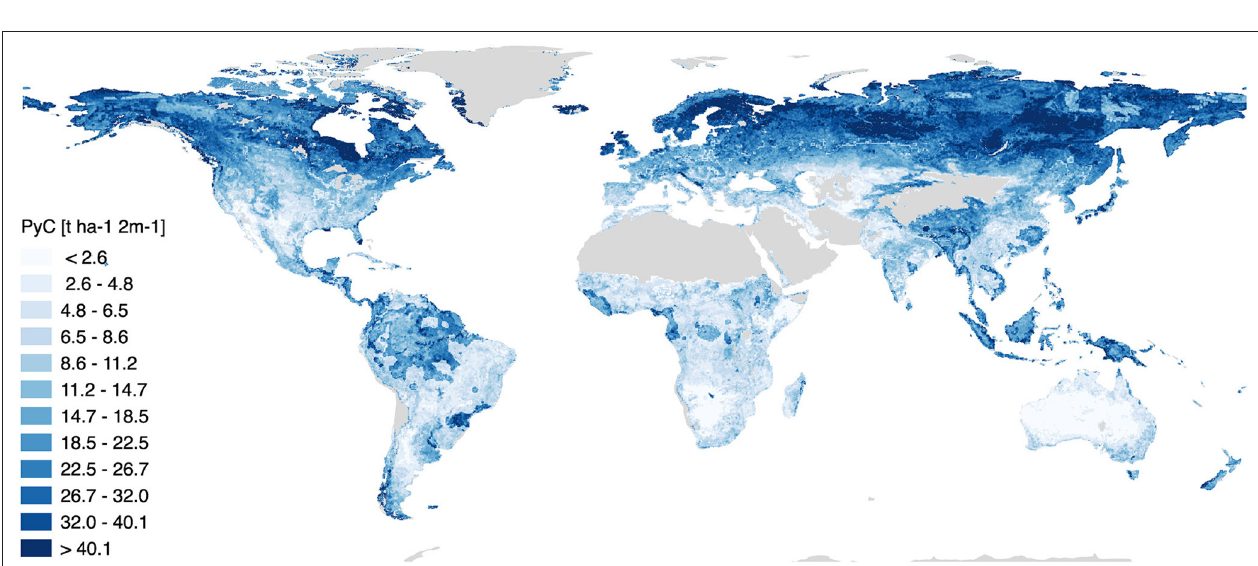
FIGURE 10 | Global predicted PyC stocks as t ha − 1 for the first 2m soil depth. Explained variance by the used linear model is 33%. BDD and total SOC content from the global dataset were used to calculate the stocks from the PyC content in SOC data. Land mass is colored in